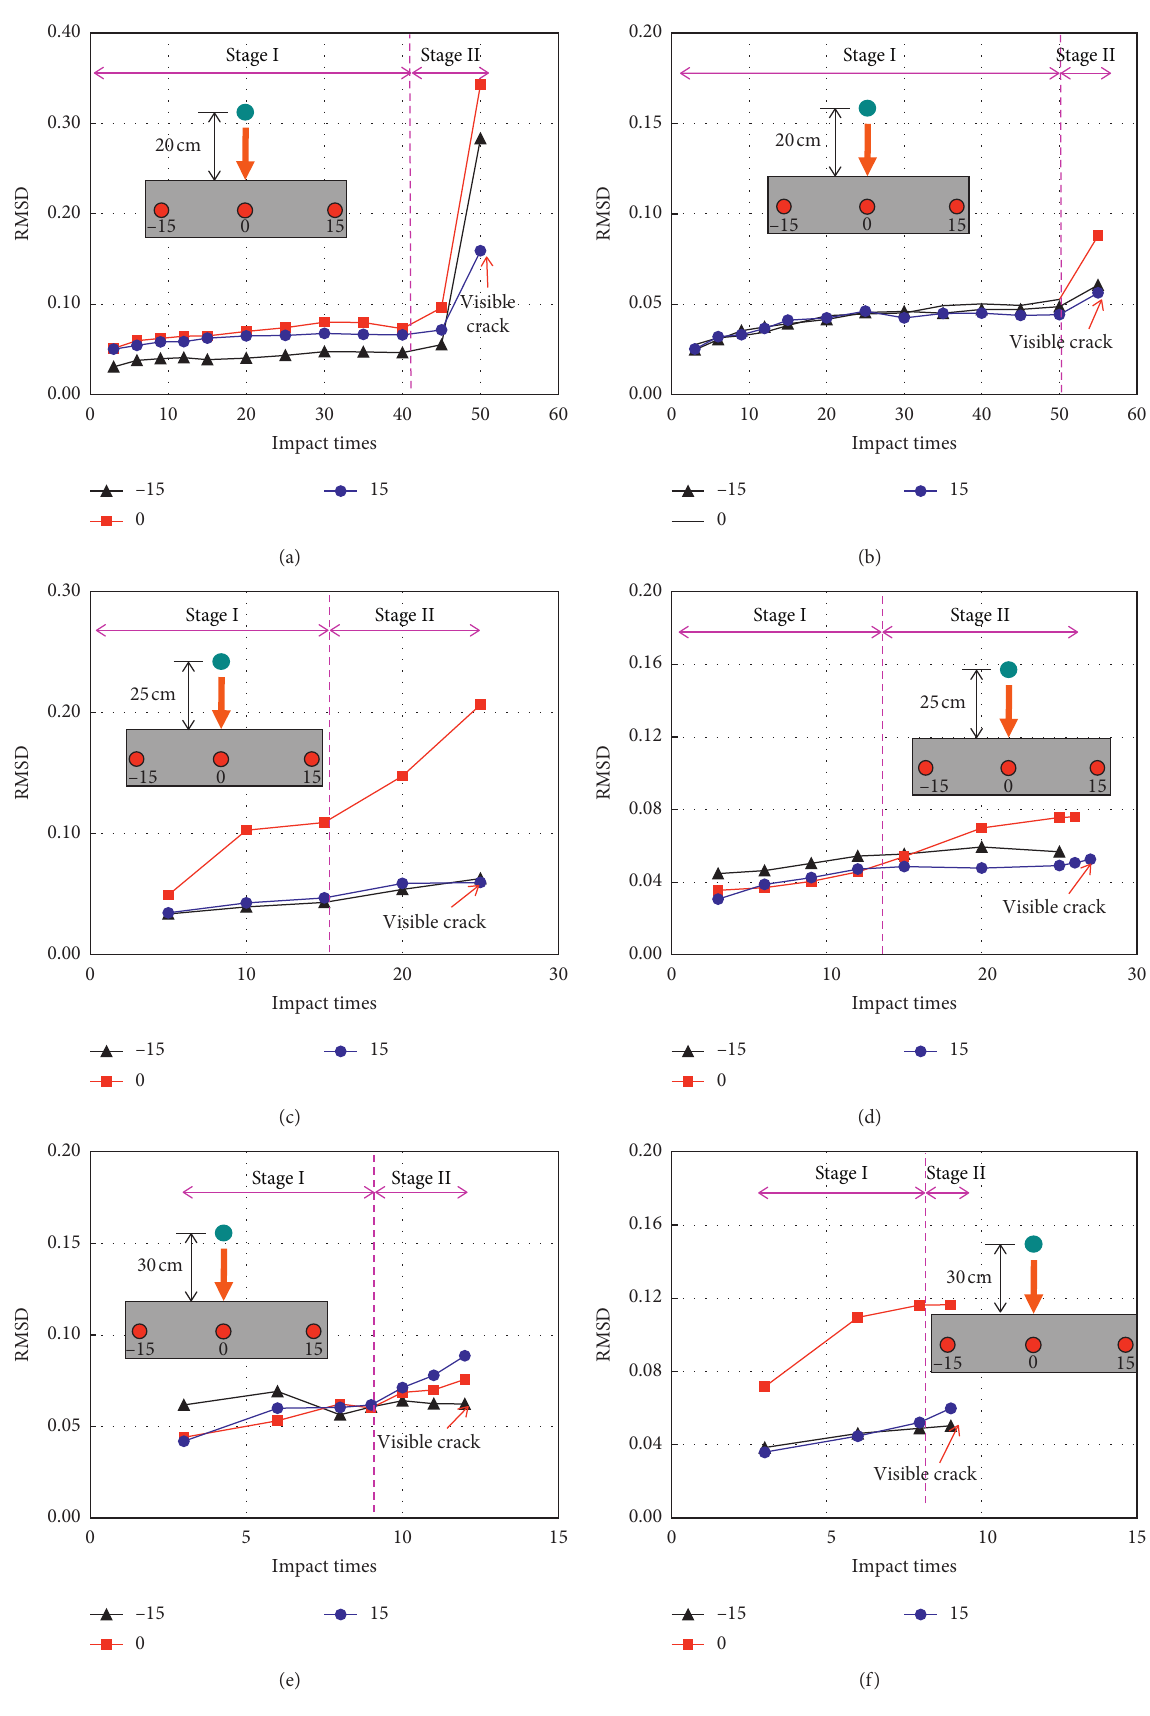
Figure 8: Damage evolution curve: (a) 20cm, sample 1; (b) 20cm, sample 2; (c) 25cm, sample 1; (d) 25cm, sample 2; (e) 30cm, sample 1; (f) 30cm, sample